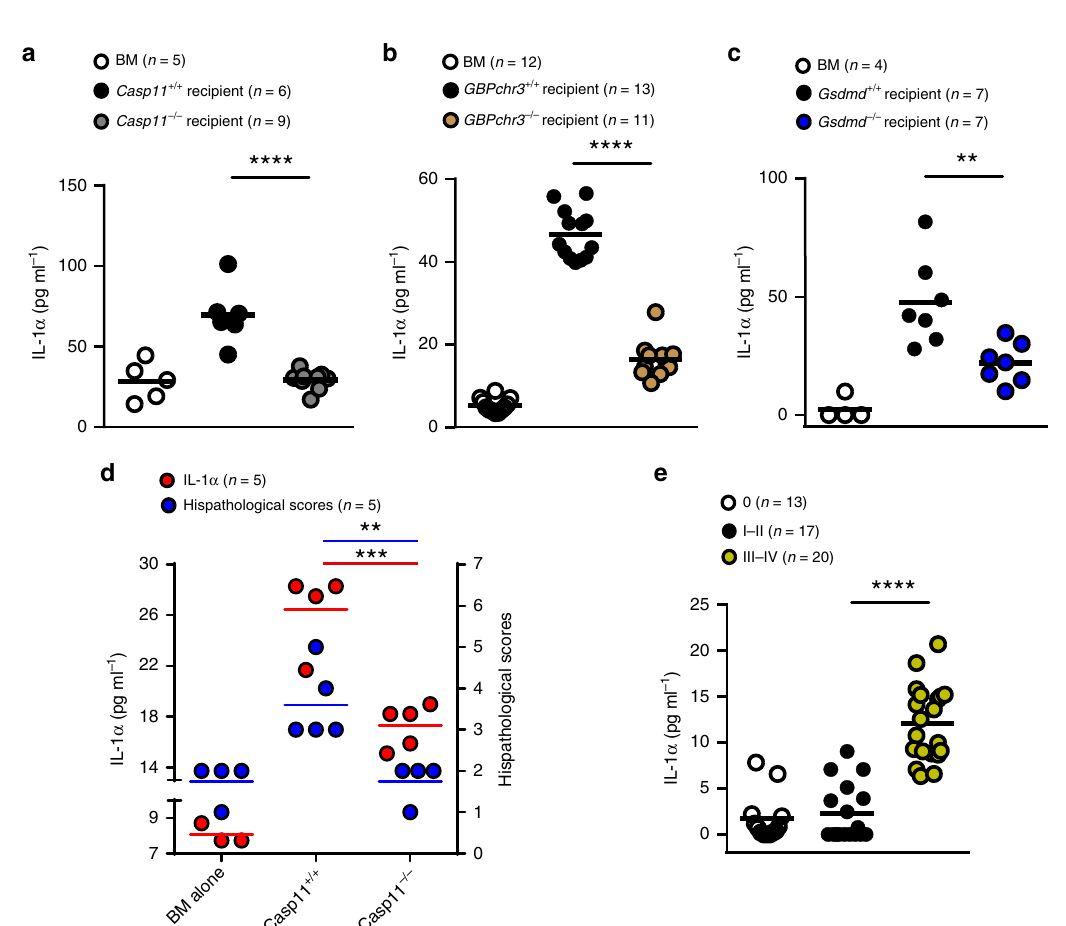
Fig. 5 Caspase-11 and gasdermin D (GSDMD) mediate interleukin-1 α (IL-1 α ) release in graft-versus-host disease (GVHD). a – c Total body irradiation